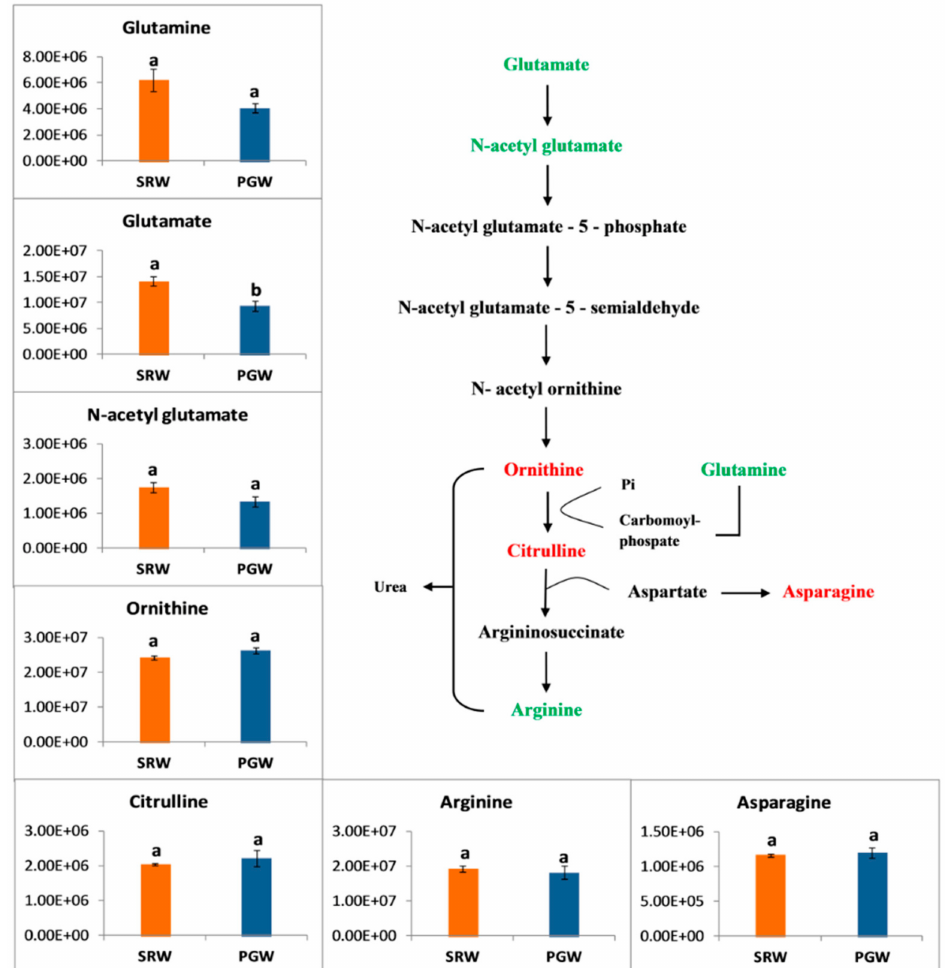
Figure 4. Y -axis shows the differences in relative contents of amino acids associated with citrulline metabolic pathway between mature fruit of pumpkin-grafted watermelon (PGW) and self-rooted watermelon (SRW). Red or green color shows the higher content of amino acids in PGW or SRW, respectively. Vertical bars represent standard error among three independent replicates. Values are the mean ± SE of three replicates. Different lowercase letters indicate significant differences at p <